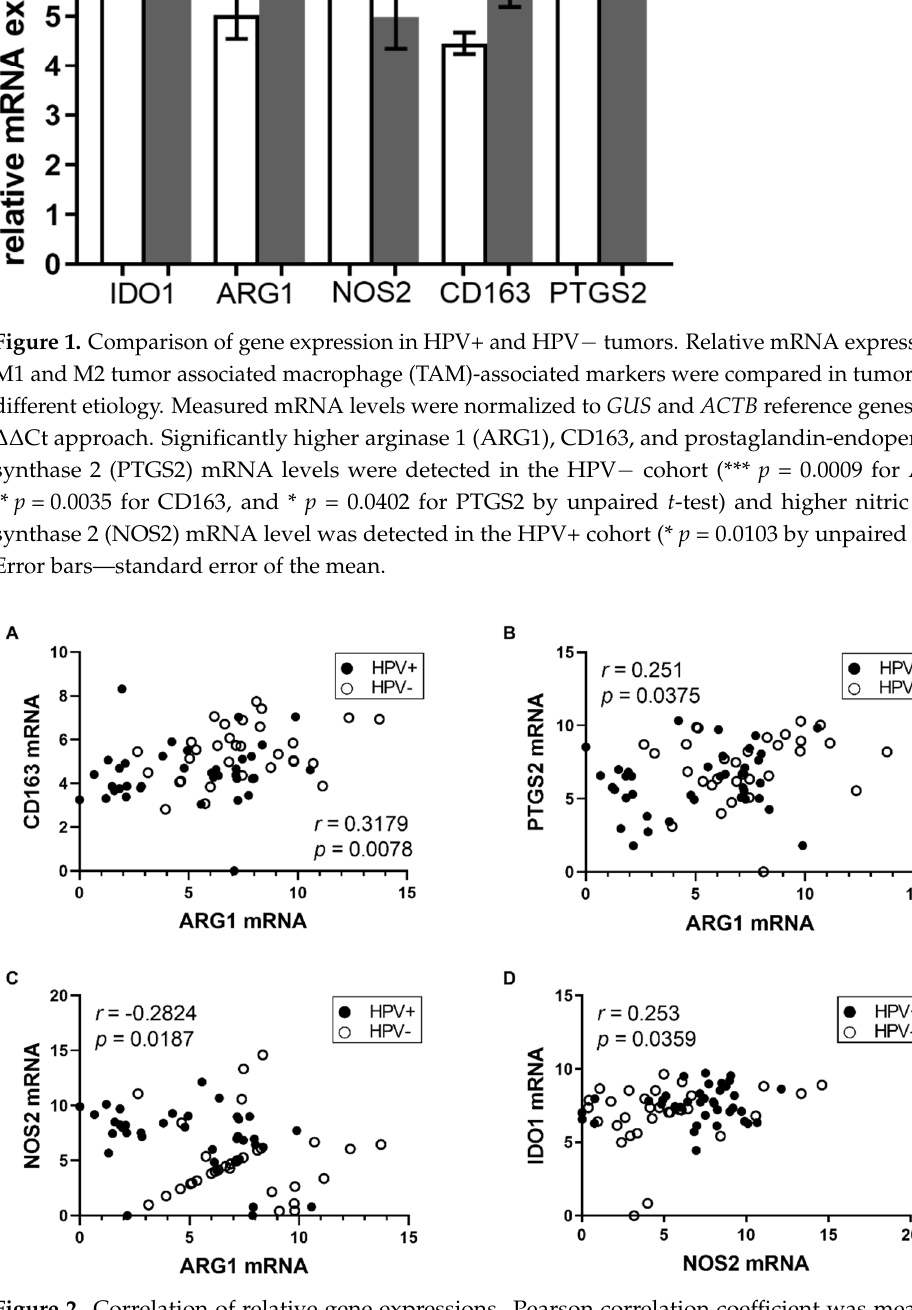
Figure 2. Correlation of relative gene expressions. Pearson correlation coefficient was measured between ( A ) ARG1 and CD163, ( B ) ARG1 and PTGS2, ( C ) ARG1 and NOS2, and ( D ) NOS2 and IDO1 relative mRNA levels.